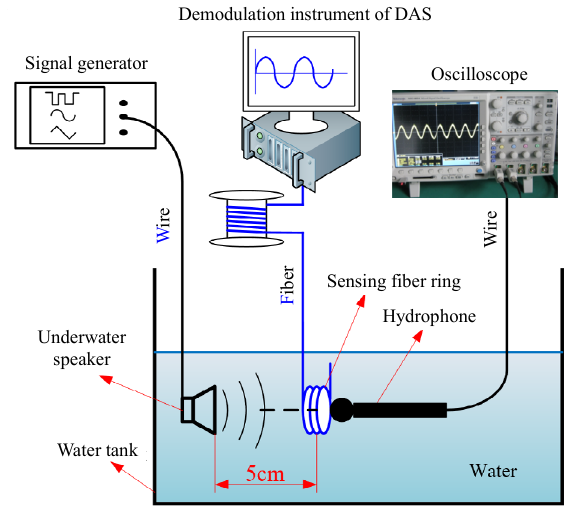
Fig. 3 Schematic diagram of underwater